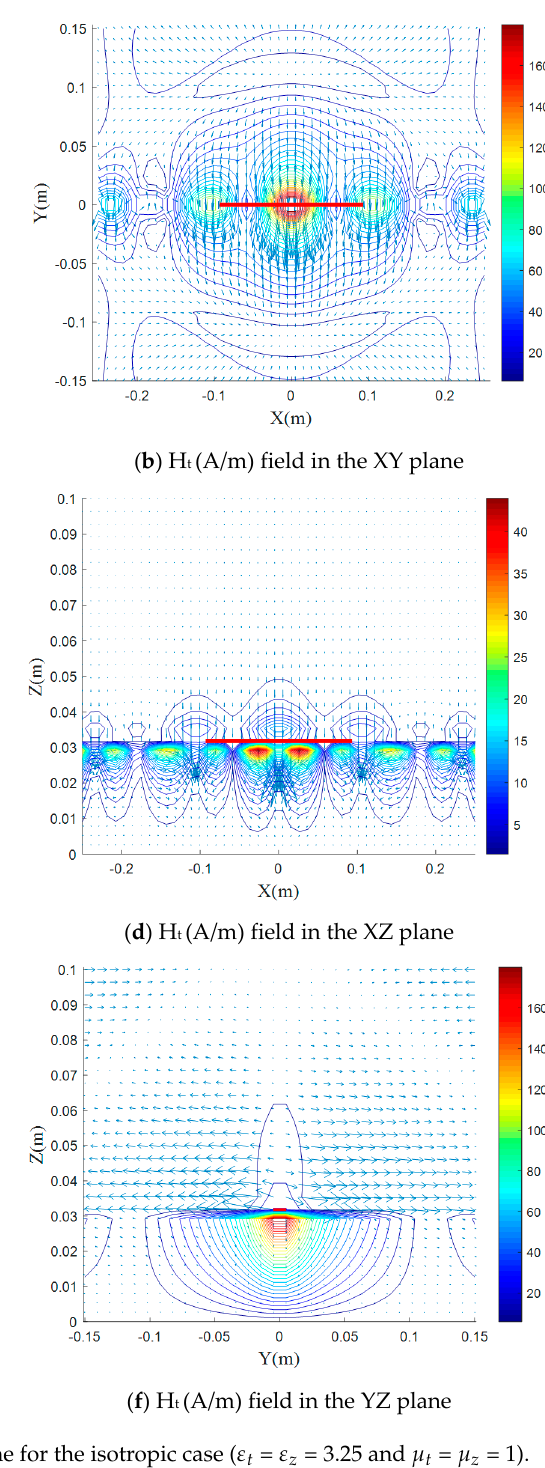
Figure 3. ( a – f ): Fields distribution plots in the transverse plane for the isotropic case ( ε t = ε z = 3.25 and µ t = µ z =